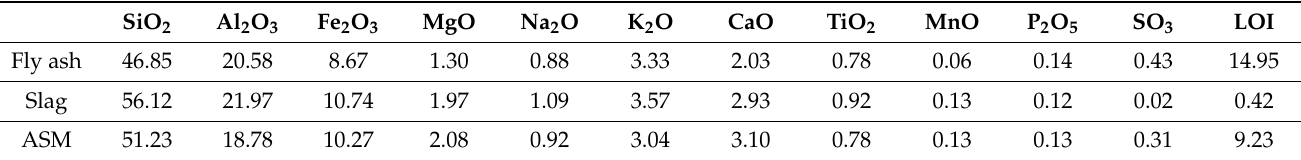
Table 2. Chemical composition of coal energy wastes.